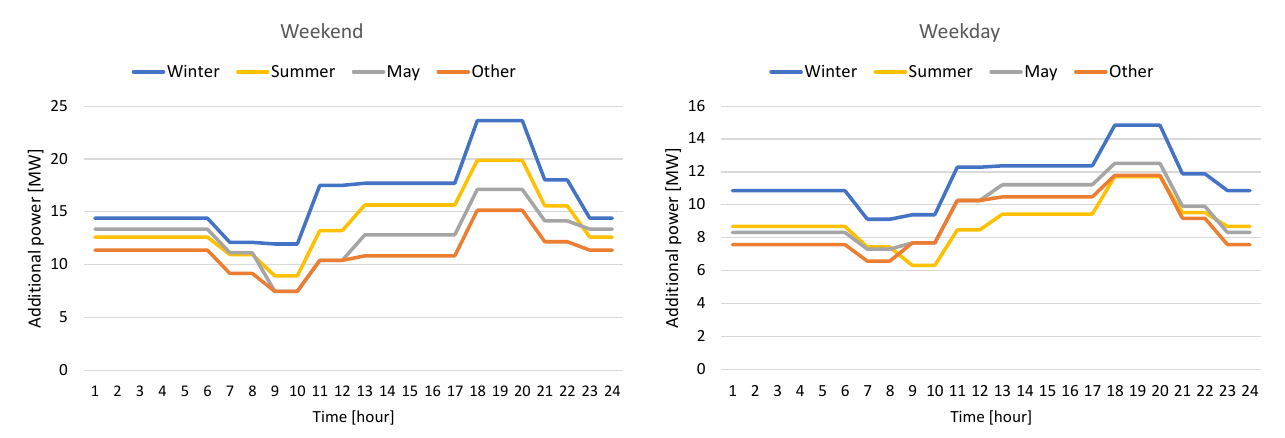
Figure 8. Additional load curve for scenario 2 (home and destination charging). Winter = November–March, summer = June–August, and other = April, September, and October.